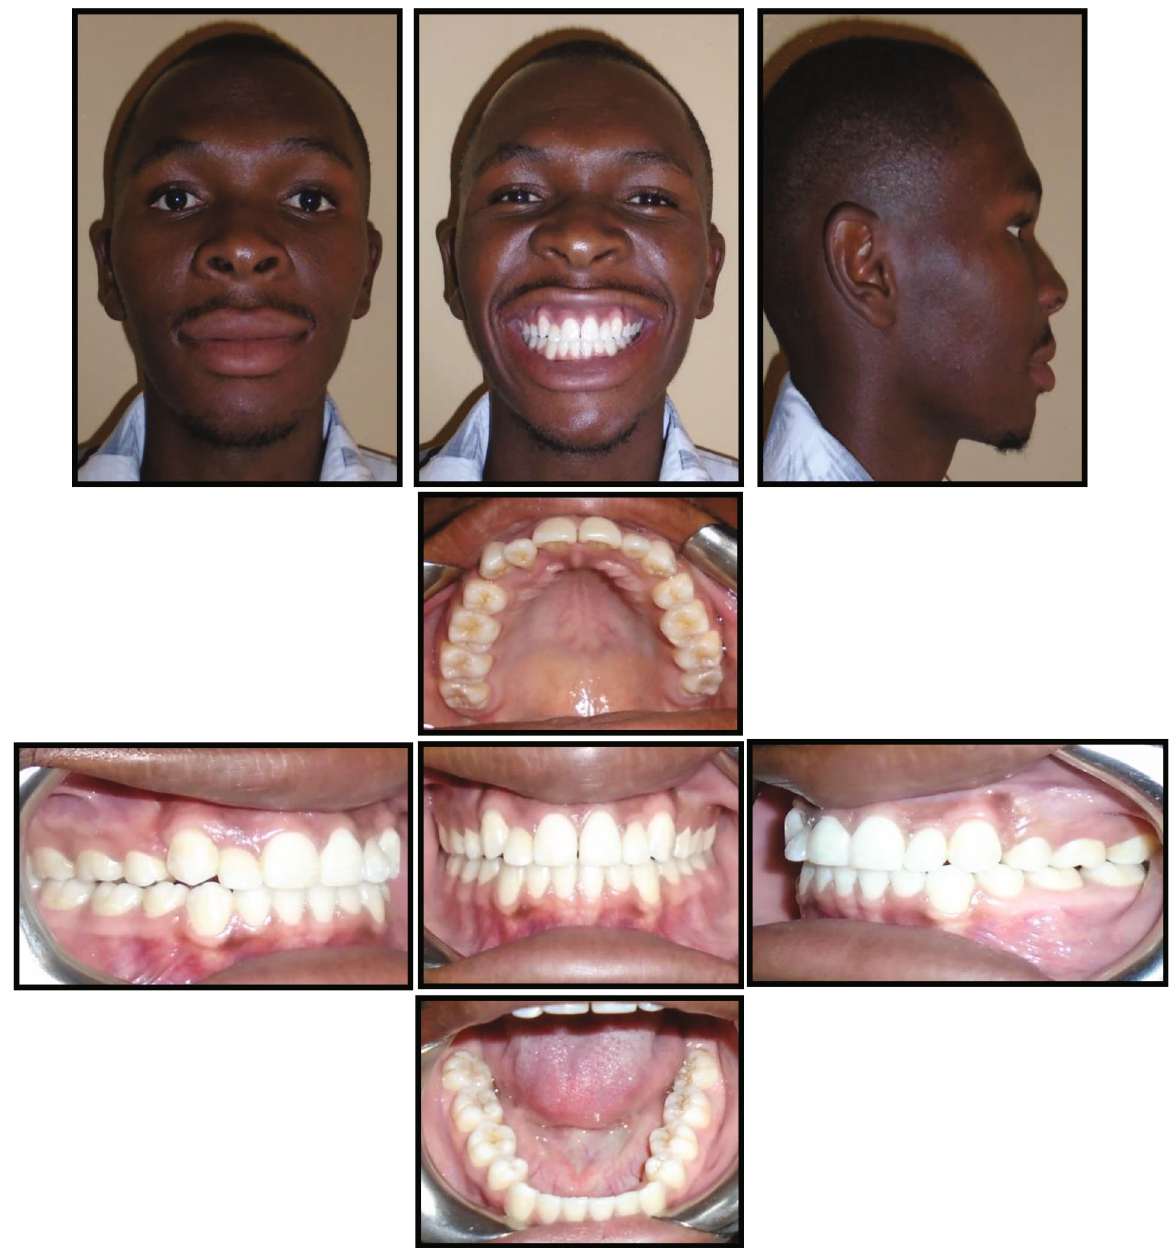
Figure 4: Posttreatment